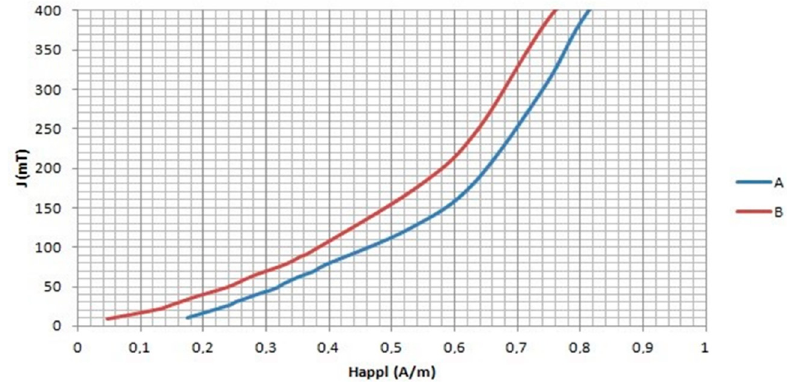
Figure 3. Magnetization curve, at low applied magnetic field, of the two nanocrystalline cores.